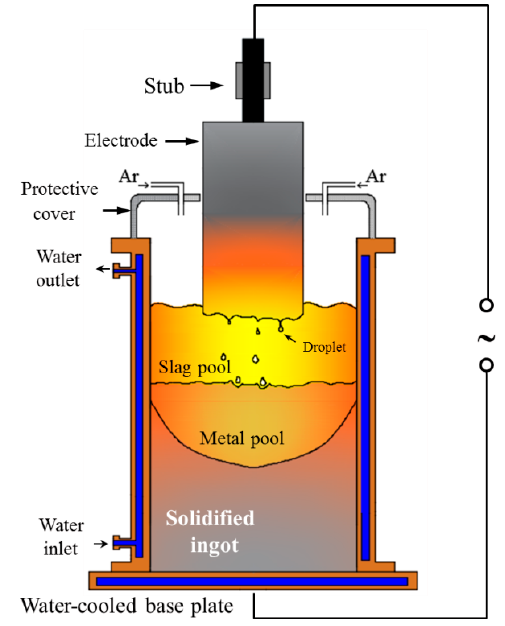
Figure 1. Schematic diagram of experimental apparatus.